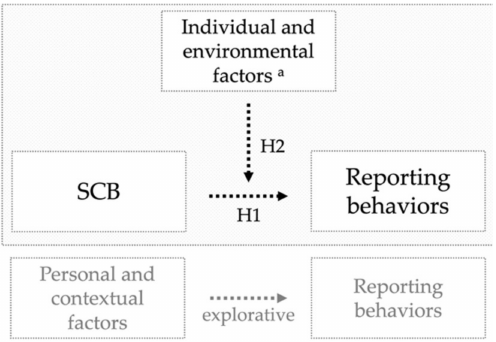
Figure 2. Own illustration of the research agenda for overview purposes only. a Individual and environmental factors = fear, shame, just culture, change goals, protection goals, and procrastination.